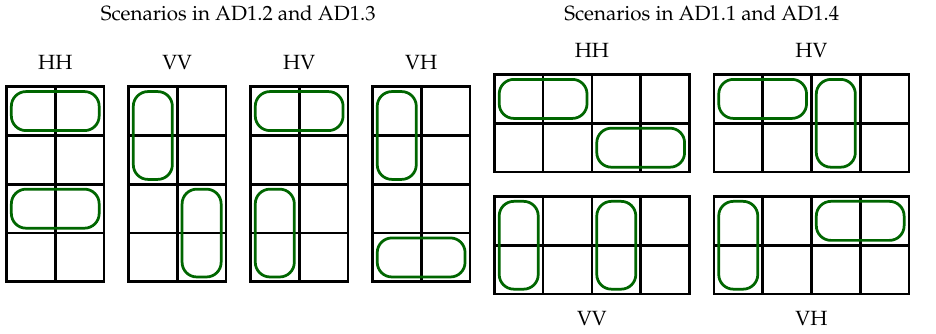
Figure 4. Location of elements with the maximum value in horizontally (H) and vertically (V) stacked quarters.